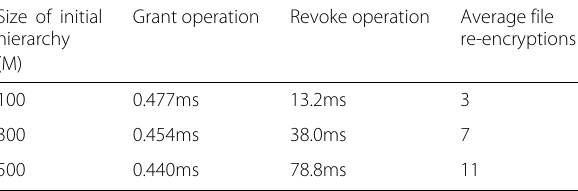
includes a file server that stores 1000 files. The file size varies from 1 MB to 2 MB. The hierarchy is implemented using Hashmap in Java by storing it as an adjacency